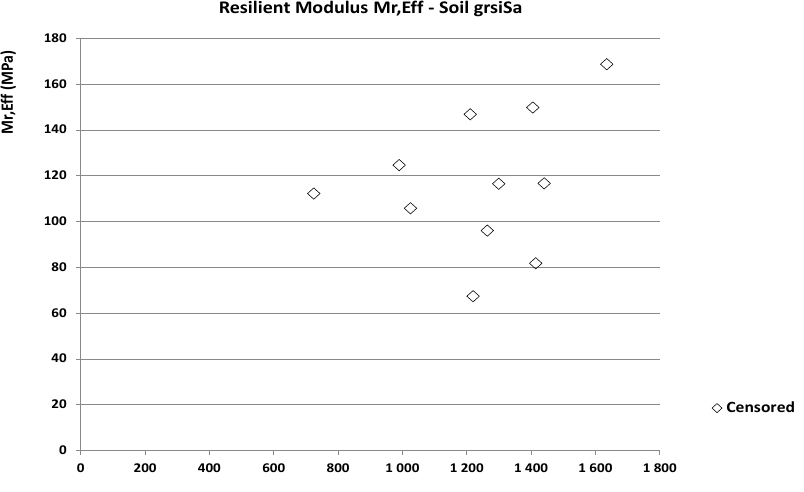
Figure 10. Resilient modulus M r,eff for soil grsiSa. Soil siGr